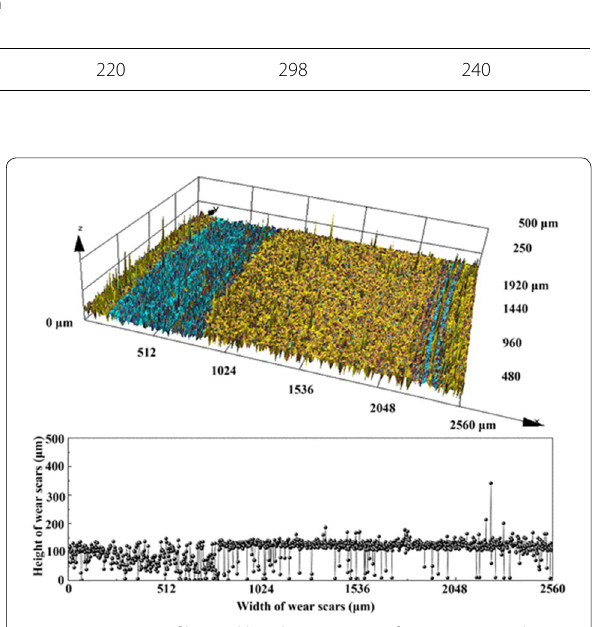
Figure 17 3-D profiles and height variations of wear scars on the